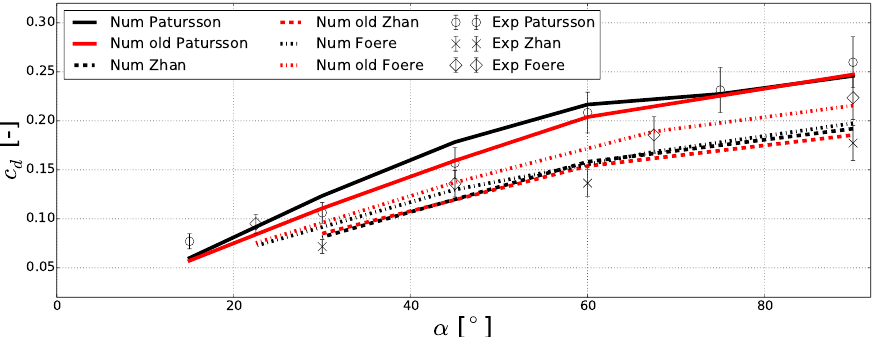
Figure 1. Comparison of the numerically predicted and measured drag force coefficients as a function of the angle of attack α . The experiments are taken from [7,24,25]. The bars indicate a 10% error margin.